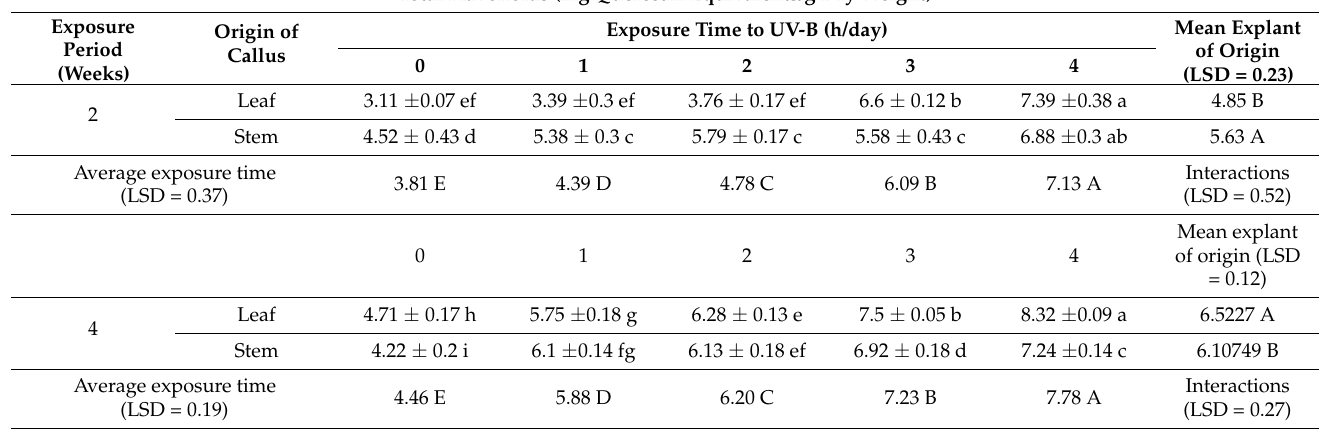
Table 5. Effect of exposure time to UV-B radiation and origin explant on total flavonoid biosynthesis in callus